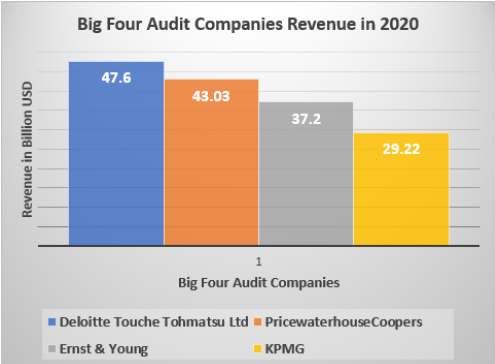
Figure 2. Big Four audit companies’ revenue in 2020. Sources: Deloitte, PwC, EY, KPMG .